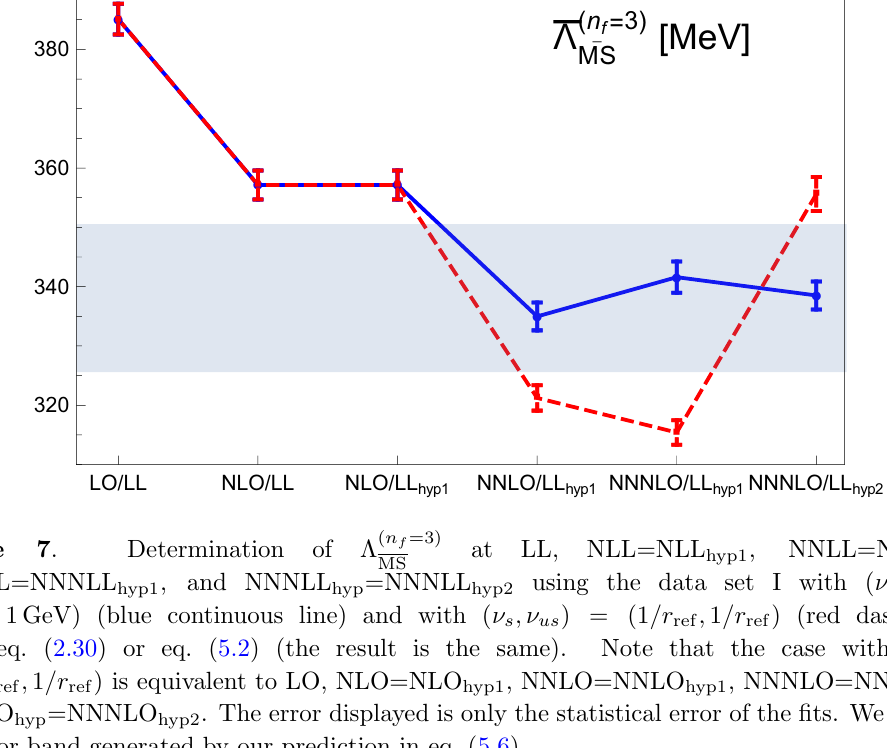
Figure 7 . Determination of (cid:3) ( n f =3) at LL, NLL=NLL hyp1 , NNLL=NNLL hyp1 , MS NNNLL=NNNLL hyp1 , and NNNLL hyp =NNNLL hyp2 using the data set I with ( (cid:23) s ; (cid:23) us ) = (1 =r ref ; 1 GeV) (blue continuous line) and with ( (cid:23) s ; (cid:23) us ) = (1 =r ref ; 1 =r ref ) (red dashed line) using eq. (2.30) or eq. (5.2) (the result is the same). Note that the case with ( (cid:23) s ; (cid:23) us ) = (1 =r ref ; 1 =r ref ) is equivalent to LO, NLO=NLO hyp1 , NNLO=NNLO hyp1 , NNNLO=NNNLO hyp1 , NNNLO hyp =NNNLO hyp2 . The error displayed is only the statistical error of the (cid:12)ts. We also show the error band generated by our prediction in eq.